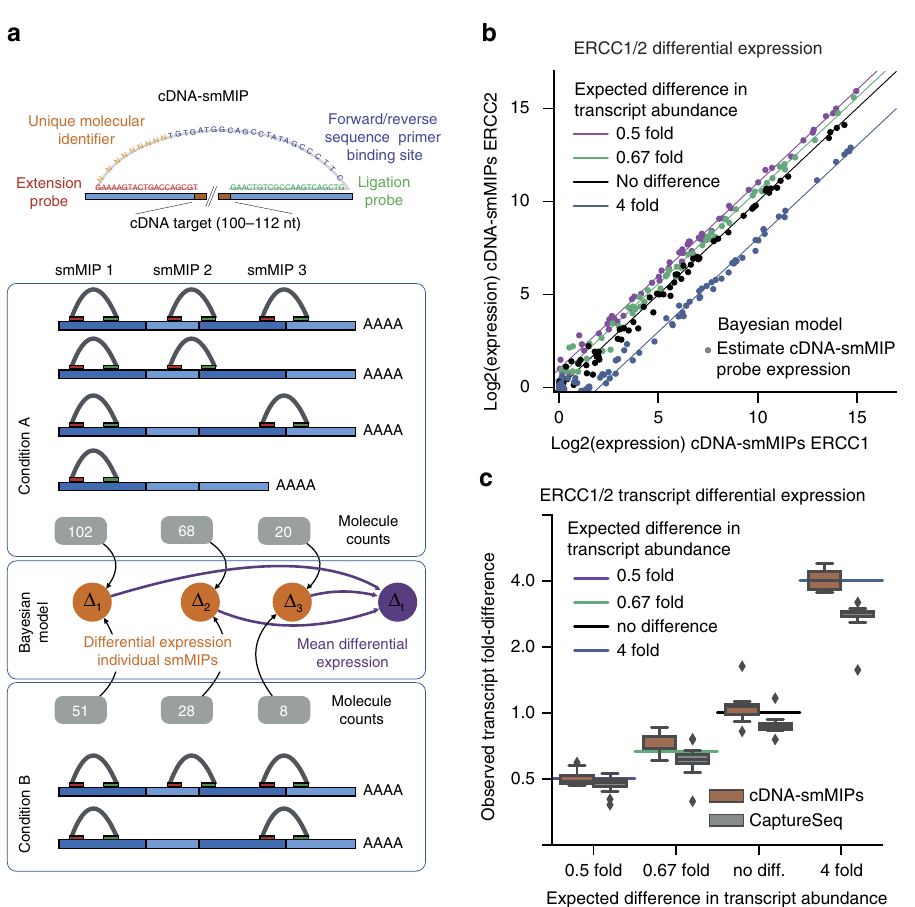
Figure 1 | Evaluation of cDNA-smMIPs for estimation of differential expression with artificial transcripts. ( a ) Outline of the approach. ( b ) Accuracy of differential expression estimates from 337 individual cDNA-smMIPs targeting 92 ERCC transcripts in condition ERCC1 and ERCC2. The 92 transcripts are divided into four groups; for each group the difference in transcript abundance between condition ERCC1 and ERCC2 is known, and is indicated by the solid lines. Four technical capture replicates were performed on respectively one cDNA sample for condition ERCC1 and one cDNA sample for condition ERCC2. The expression value for each smMIP is estimated using a Bayesian model. Data points are coloured according to their expected expression fold difference. ( c ) Comparison of differential expression quantification by cDNA-smMIPs and the previously published method CaptureSeq 5 that performs targeted RNA-Seq by biotin-labelled oligonucleotide hybridization. Only transcripts with log2-expression values of 4 4 were included for both methods. Differential expression estimated with the Bayesian model from respectively four ERCC1 and ERCC2 cDNA-smMIPs capture replicates is compared with differential expression estimates from respectively 4 ERCC1 and 5 ERCC2 replicates for CaptureSeq (see respectively Supplementary Tables 1 and 2 for